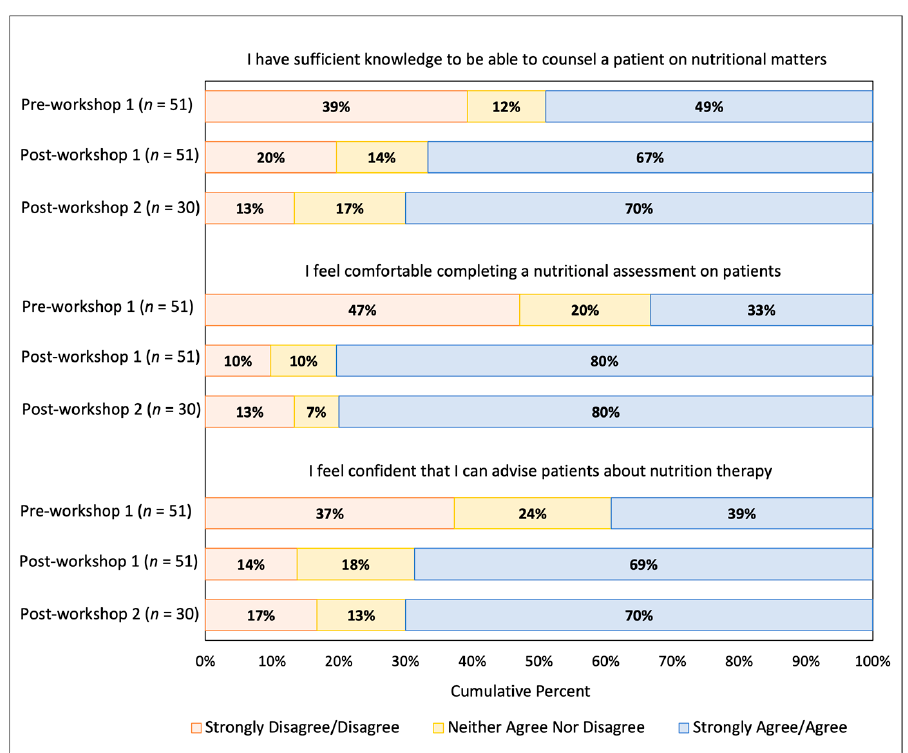
Figure 2. Cumulative percent of student responses for each question at the pre-workshop 1, post- workshop 1, and post-workshop 2 time-points.